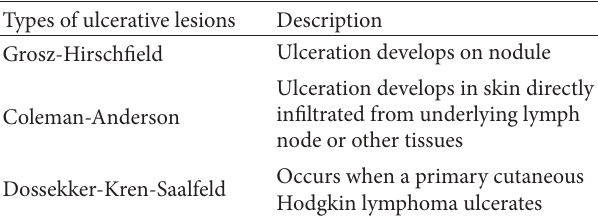
Table 2: Types of ulcerative lesions in cutaneous Hodgkin lym-